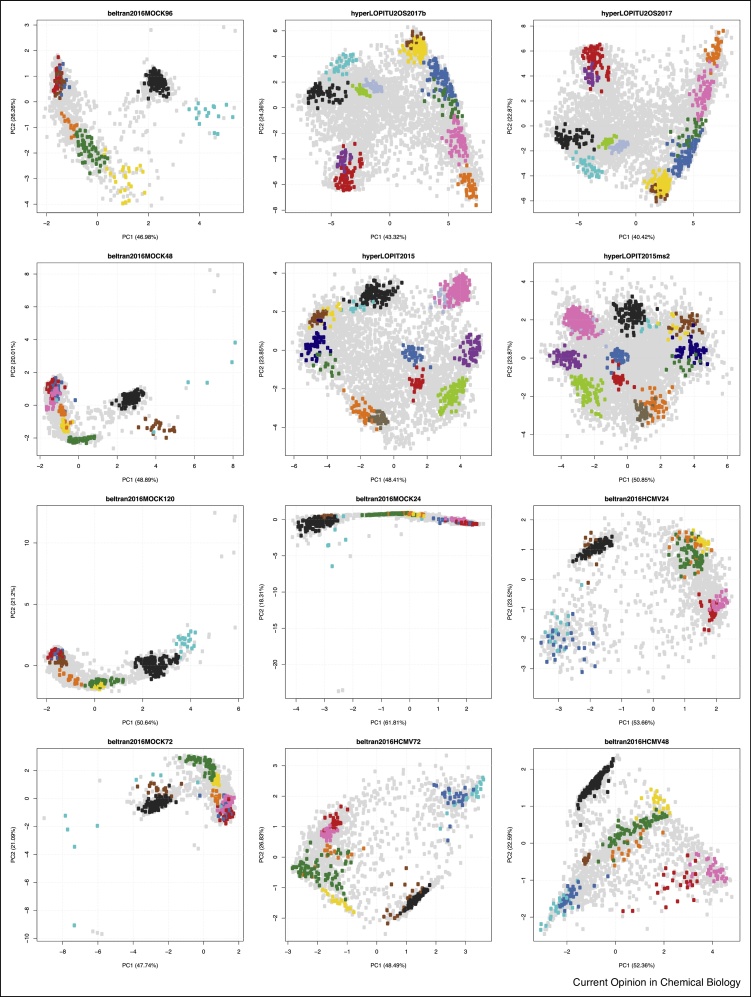
PCA plots for the 29 experiments used in this study. PC 1 and 2 were used except for itzhak2016stcSILAC, where PC 1 and 3 were used to conform to the original authors figures. The experiments are ordered according to the median average between cluster distance (see Figure 8). The percentage of variance explained along the 2 PCs on the plots can be found in Table 1. Figures have been generated using the plot2D function from the pRoloc package.